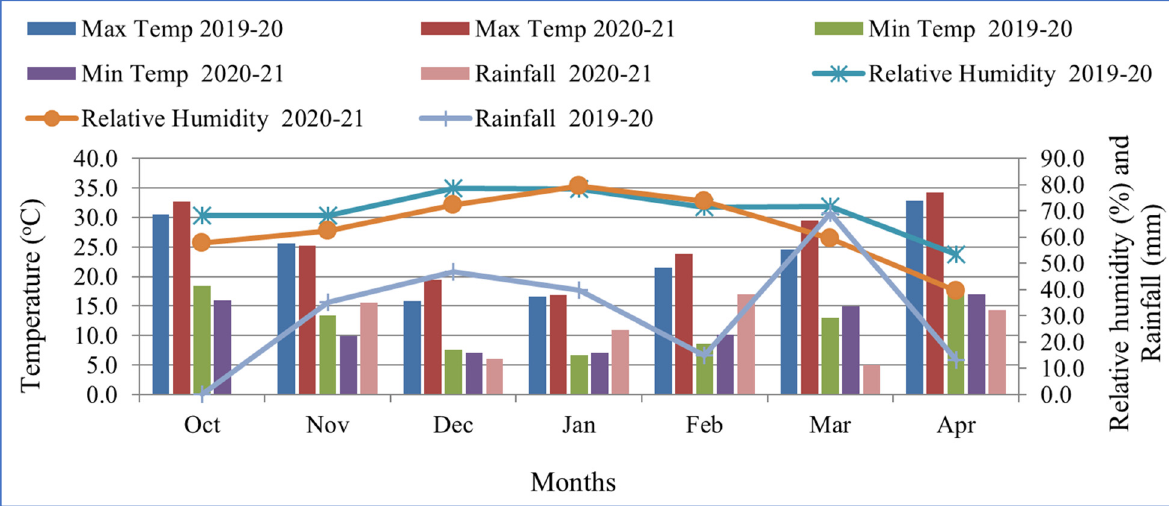
Figure 1. Monthly average maximum and minimum temperature, relative humidity and rainfall of the study area.